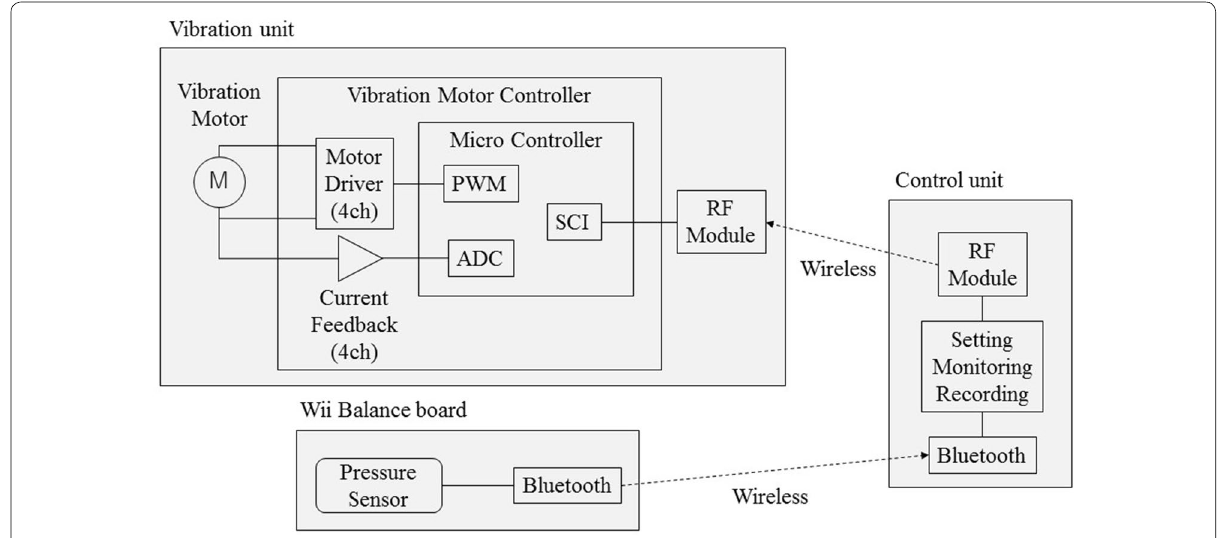
Fig. 1 Configuration